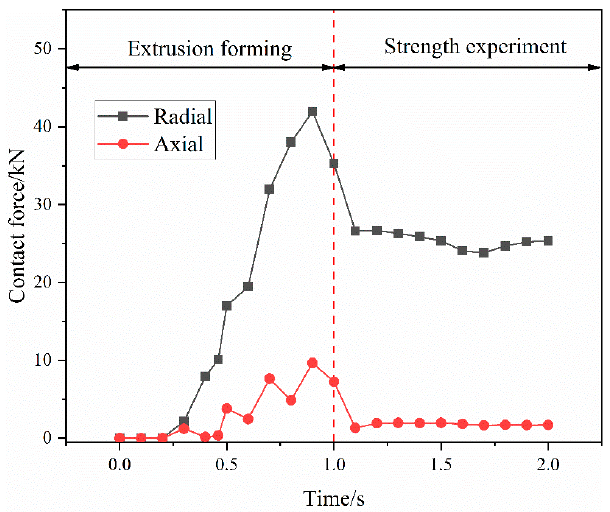
Figure 9. The contact-force variation curve between the extrusion ring and the fittings body.